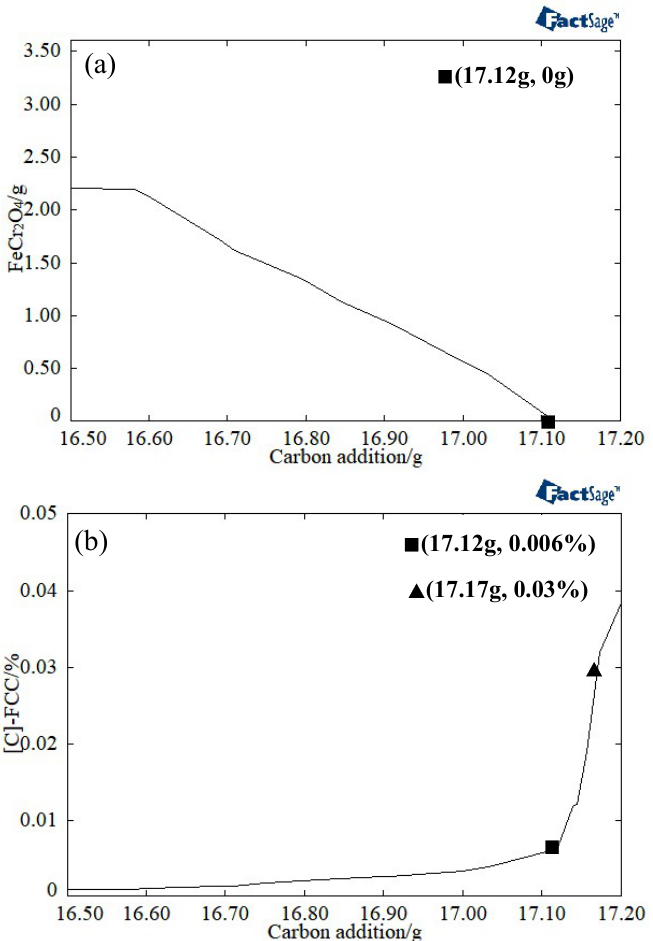
Figure 9. Effect of carbon addition at 10 −4 atm and 1200 °C; ( a ) amount of FeCr 2 O 4 ; and ( b ) carbon content in FCC.